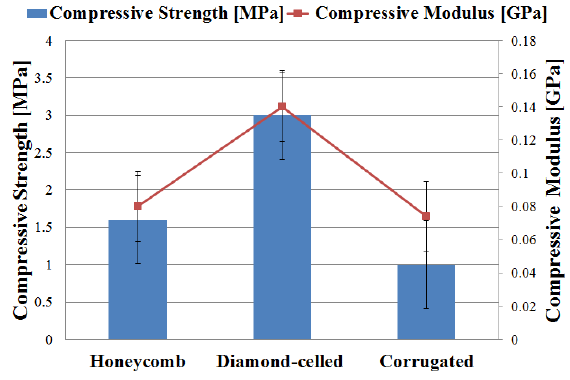
Figure 5. The compressive strength/modulus of the sandwich specimens.